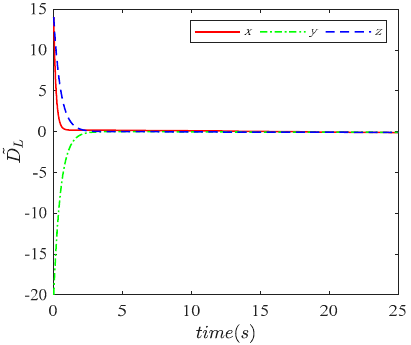
Figure 10. Disturbance estimation errors of MAV.